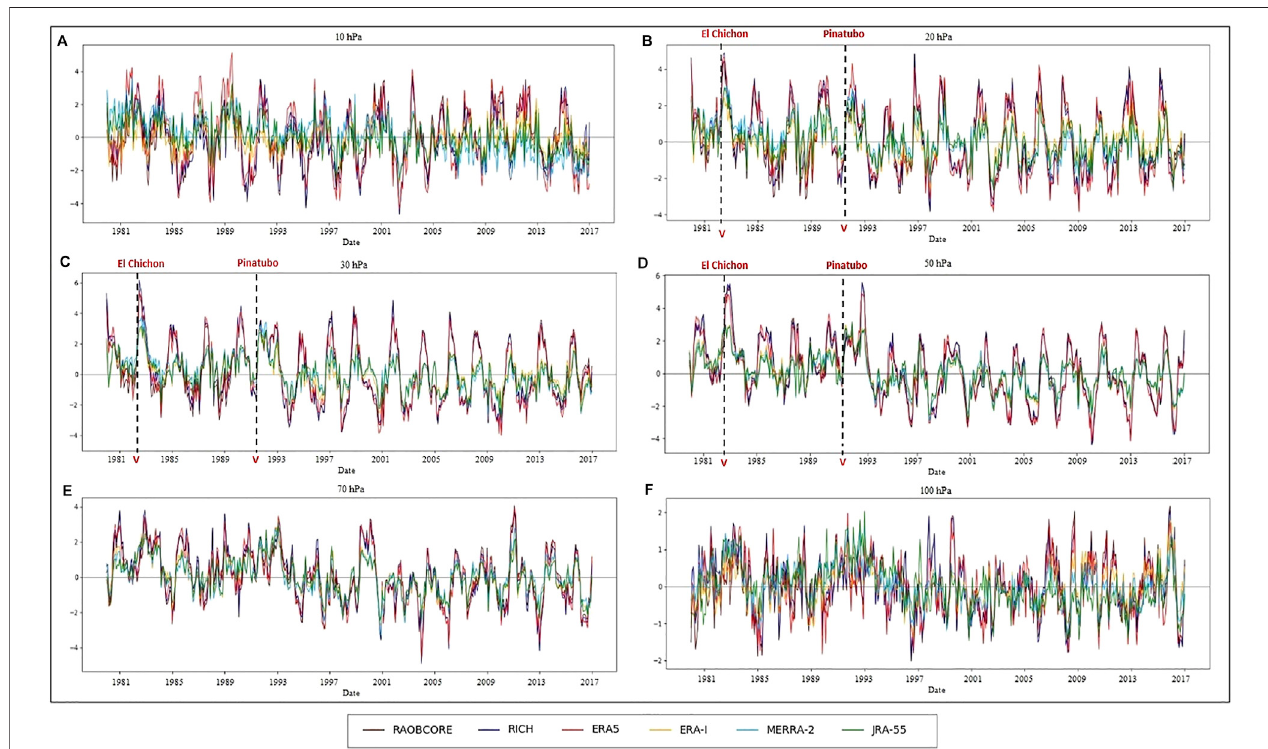
FIGURE 8 | Monthly temperature anomalies at the region 10 ° S - 10 ° N of the radiosonde observations (RAOBCORE and RICH) and the four reanalysis datasets (ERA5, ERA-Interim, MERRA-2, and JRA-55), for the vertical levels (A) 10 hPa, (B) 20 hPa, (C) 30 hPa, (D) 50 hPa, (E) 70 hPa, and (F) 100 hPa, over the